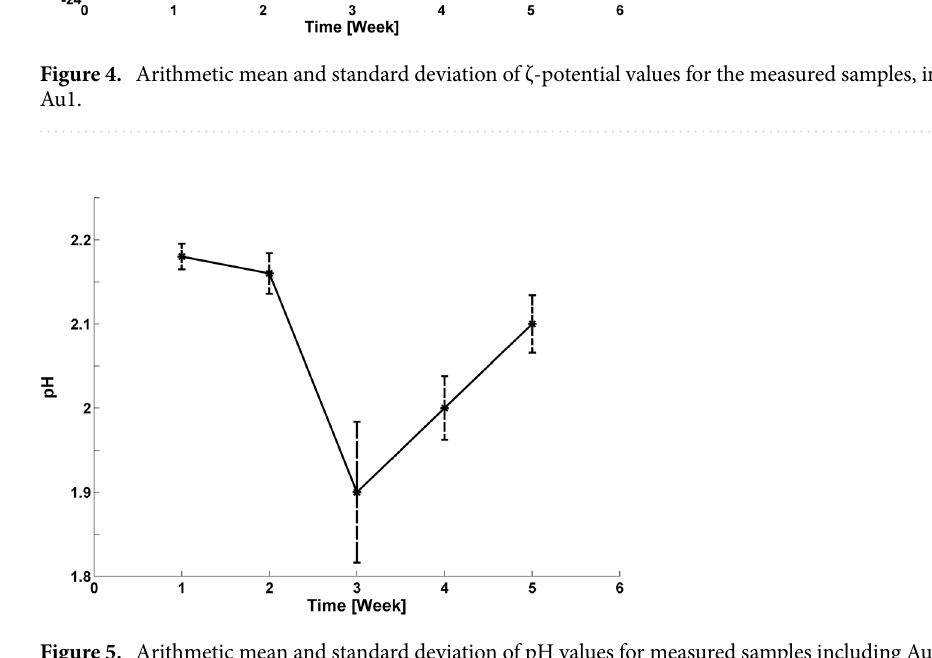
Figure 5. Arithmetic mean and standard deviation of pH values for measured samples including